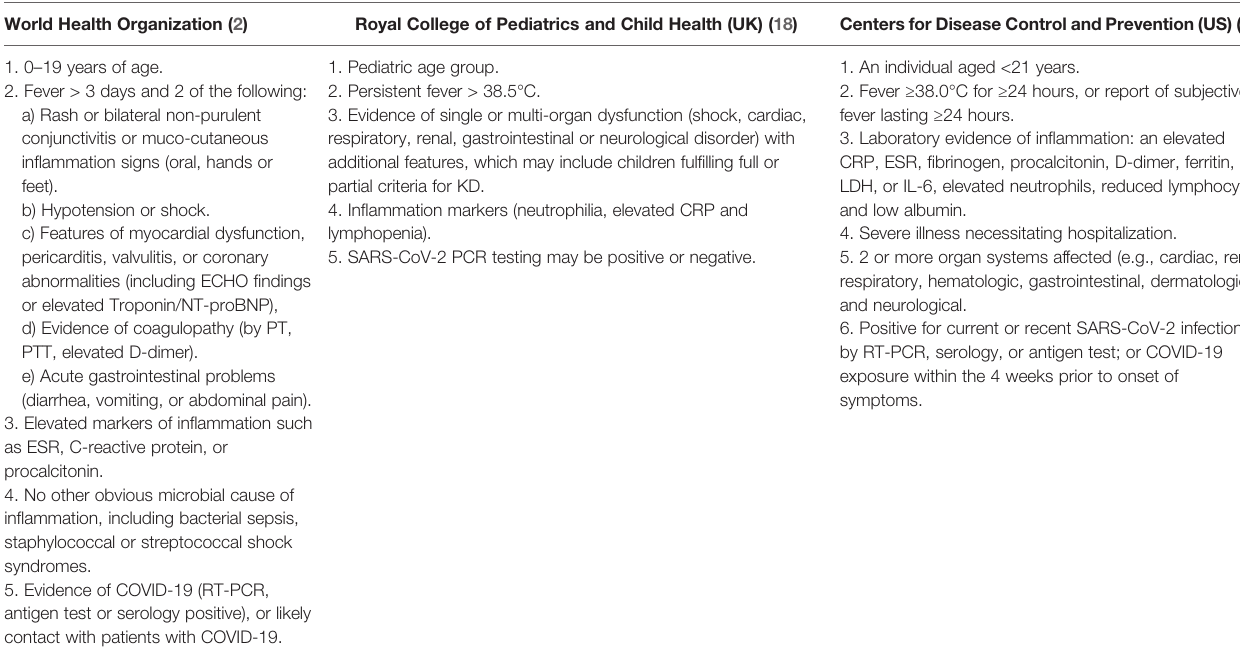
TABLE 1 | Diagnostic criteria for